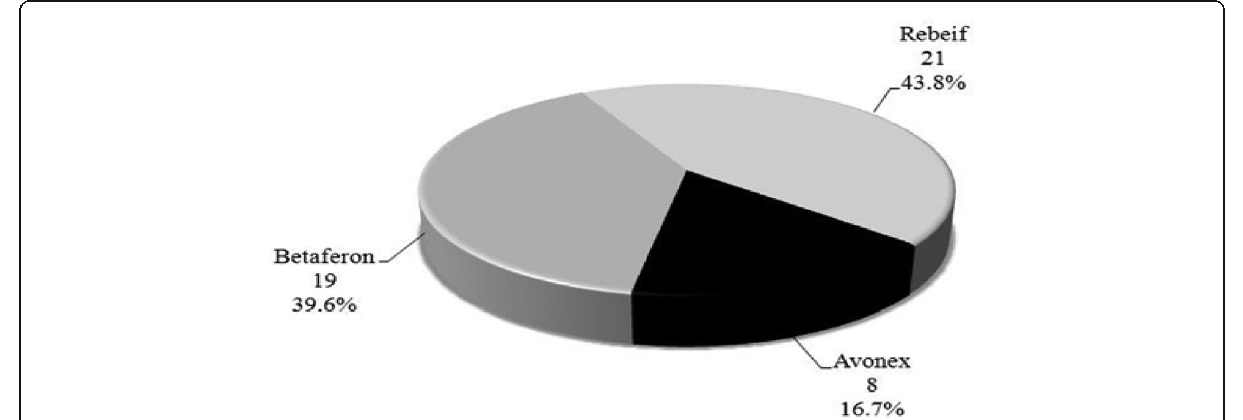
Fig. 1 Distribution of the studied cases according to type of DMT received at the baseline visit ( n =